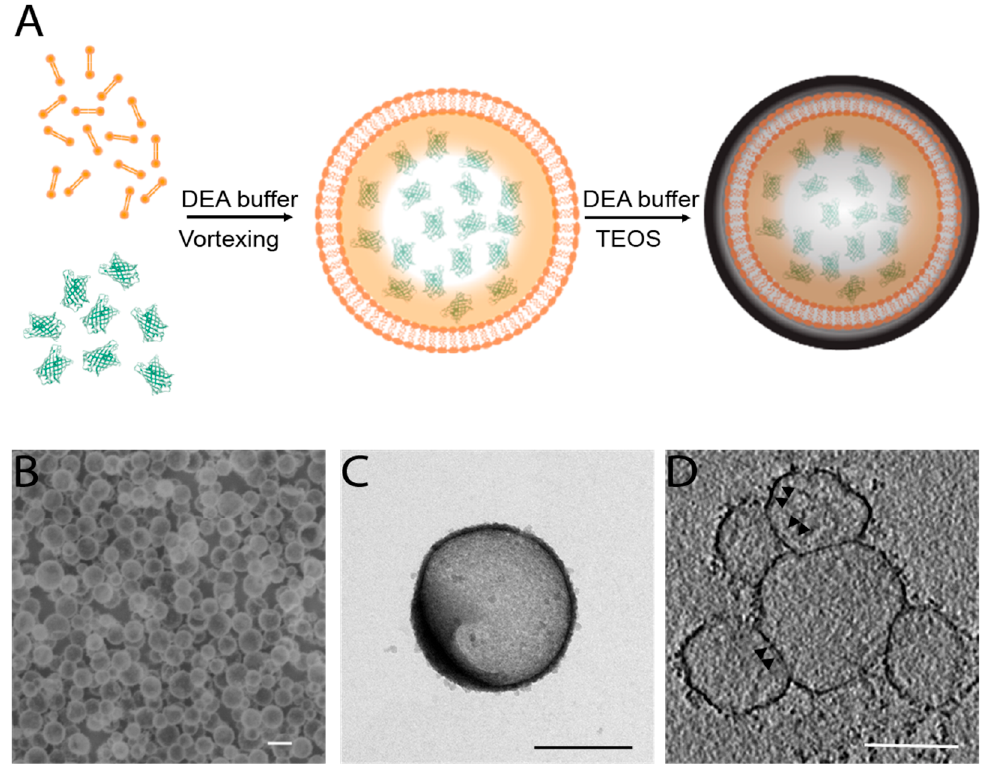
Figure 1. Schematic representation of nanoparticle synthesis ( A ). SEM characterization of the obtained nanoparticles, scale bar 200 nm ( B ). TEM image of a single Aequorea coerulescens green fluorescent protein (AcGFP)-loaded nanoparticle, scale bar 200 nm ( C ). Averaged tomographic slice of several AcGFP-loaded nanoparticles. Black arrows point to the lipid layer present underneath the silica layer (darker contour) that delimit the nanoparticles, scale bar 100 nm ( D ).